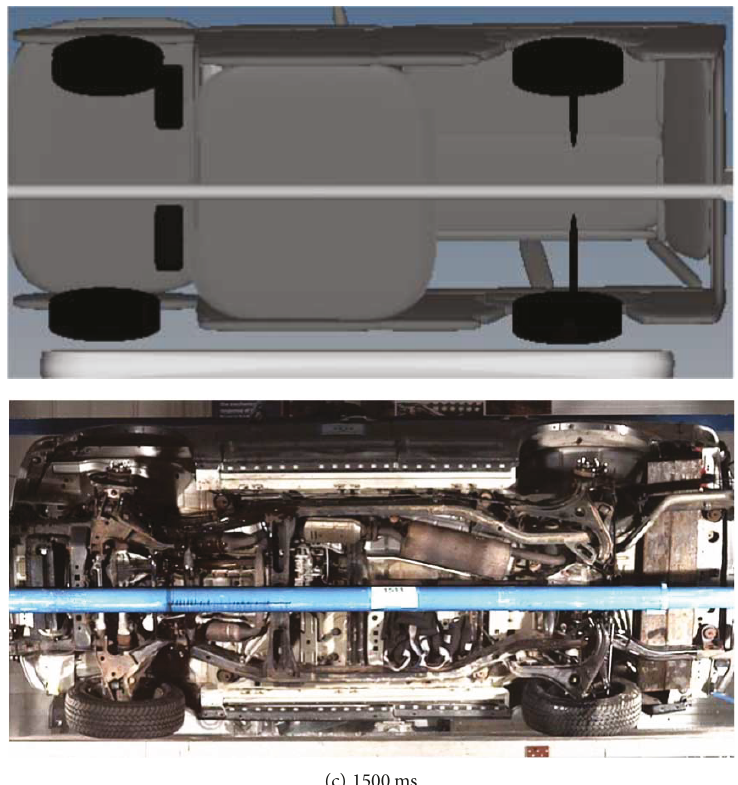
Figure 3: Vehicle rollover trajectory